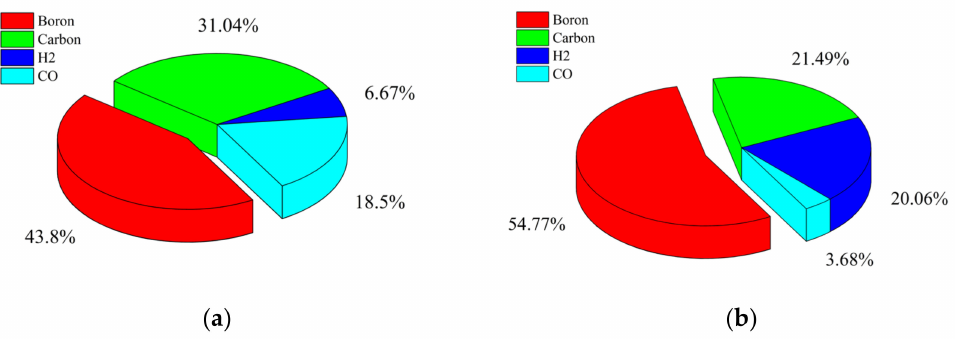
Figure 5. ( a ) Main energy-containing components in the fuel-rich gas; ( b ) main energy proportions in the fuel-rich